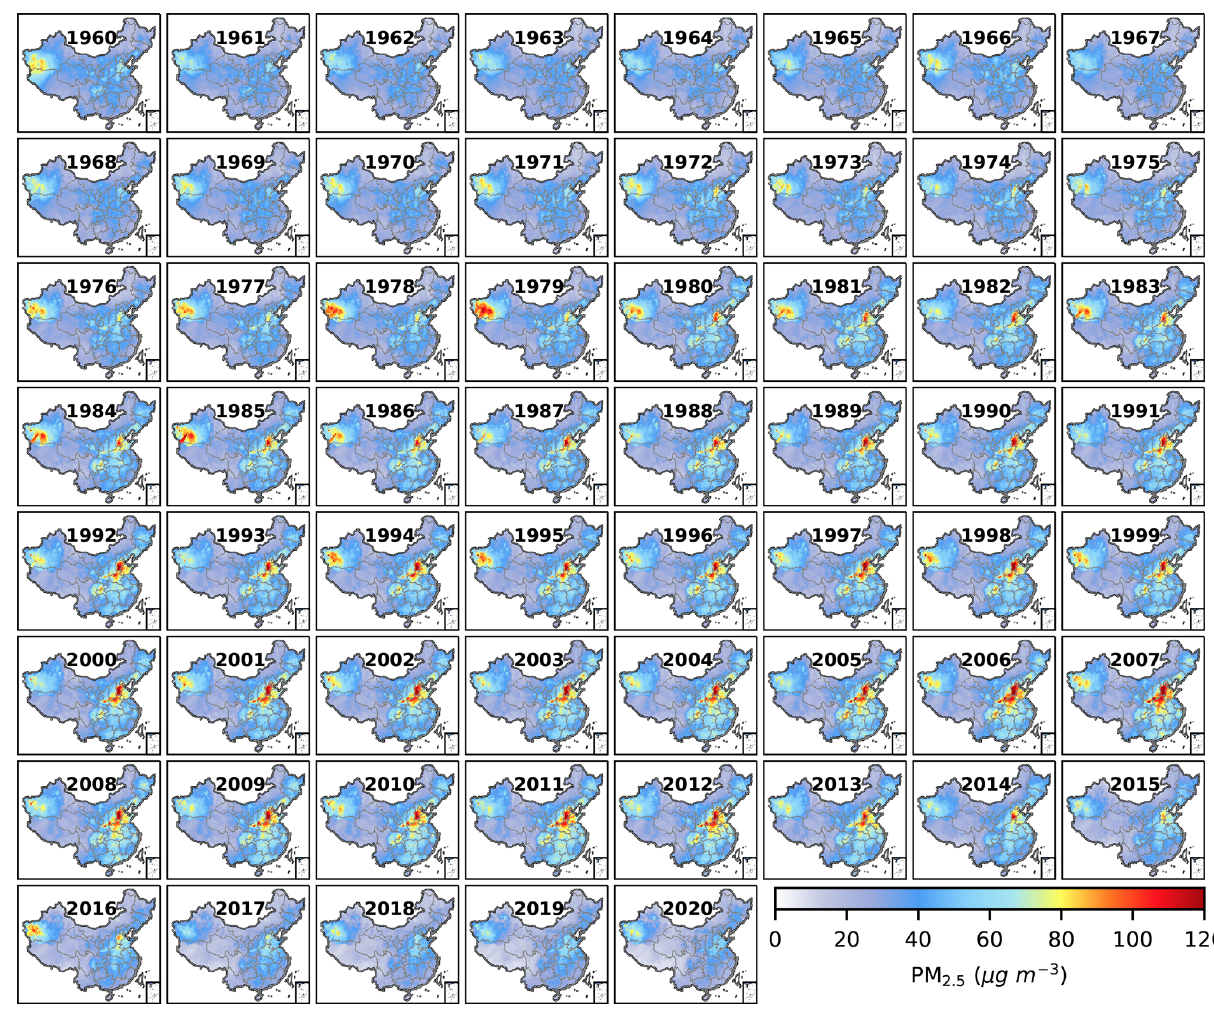
Figure 7. Gridded distribution of annual average PM 2 . 5 mass concentration from 1960 to 2020.